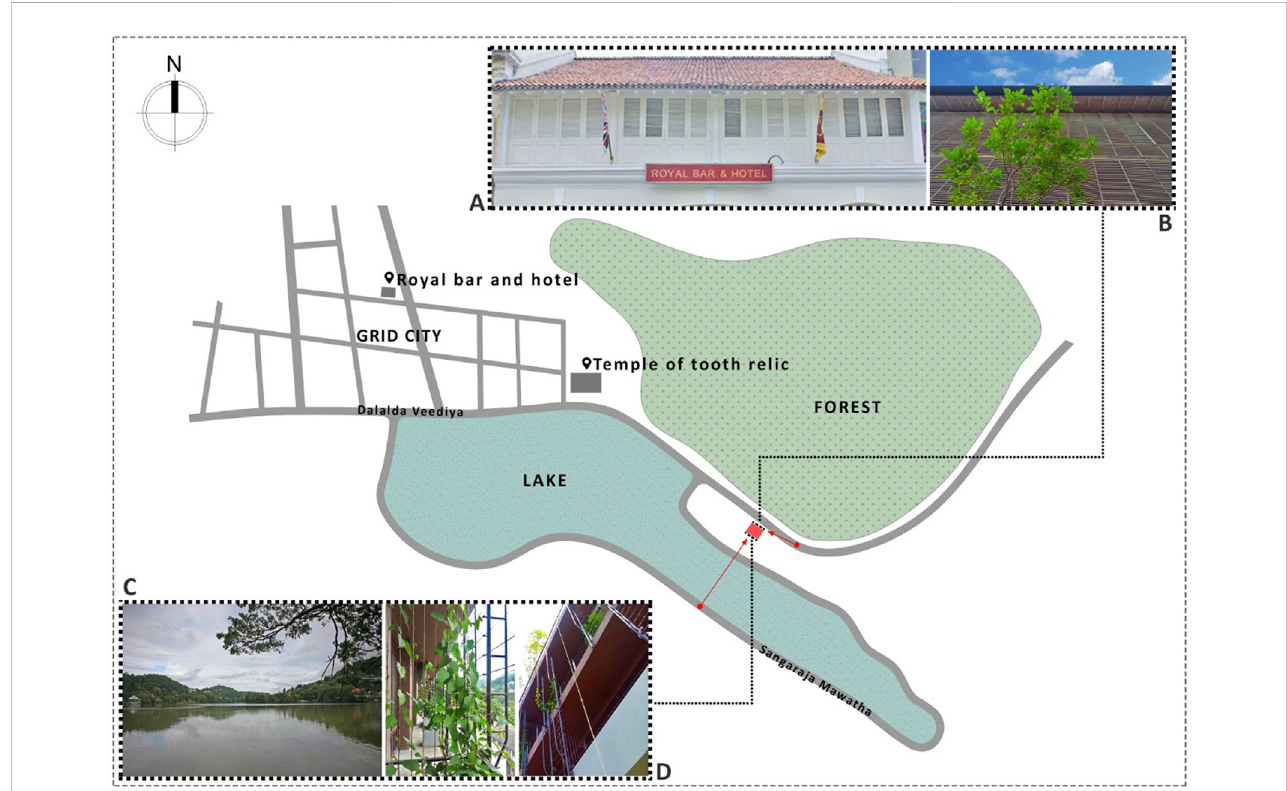
FIGURE 11 Cityproject:locationmap. (A) Façadeofahistoricalbuildinginthegridcity;timbershuttershavetraditionallybeenusedtoscreenbalconies andloggias; (B) thenewtimber-shutterscreenfrontingthestreetleadingtothegridcity (C) panoramicviewofgreeneryacrosstheKandylake; (D) creepersrunningonthe façade system facing the lake.